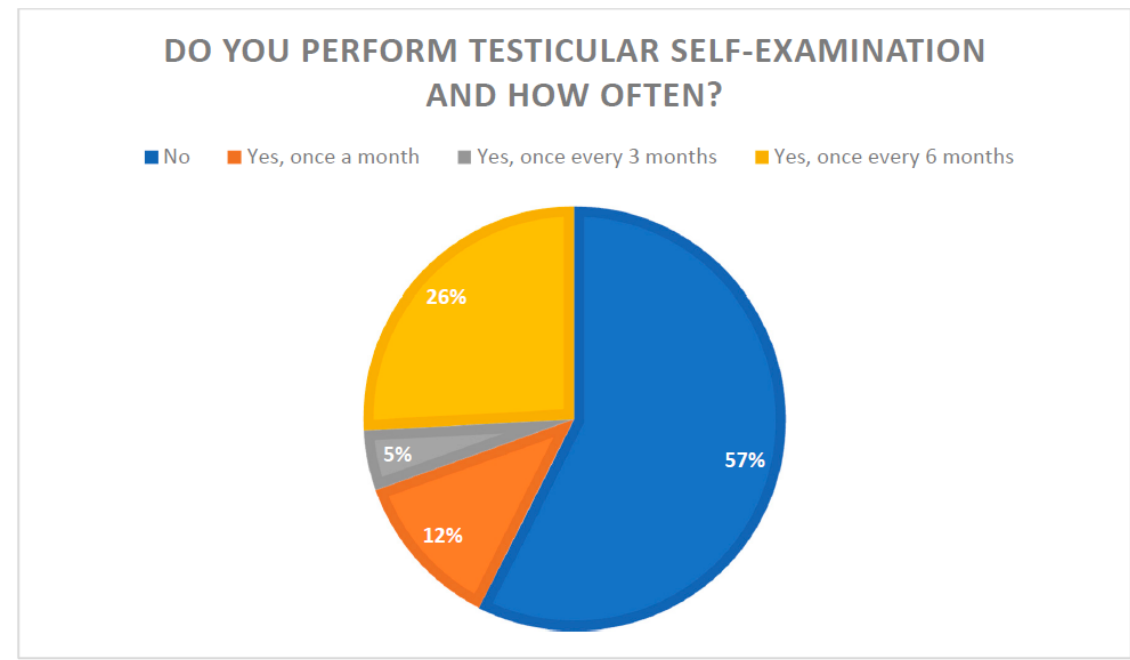
Figure 1. The results of respondents’ answers to the question “Do you perform testicular self-examination and how